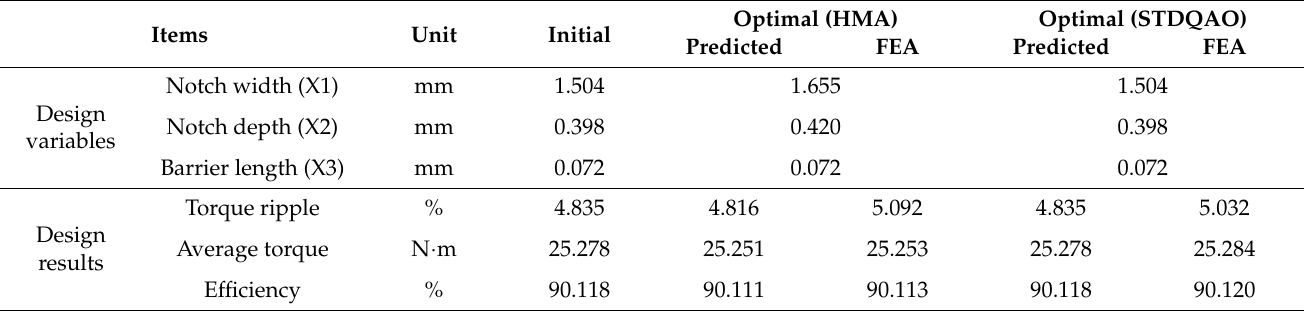
Table 4. Optimization